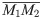
Mapping MT segments from the 2D plane back to the 3D surface.The inverse quaternion rotation operator of ΔABC is applied to the MT segment M1M2¯, and a similar operation is performed on MT segment M2M3¯ of ΔADC. If ΔABC and ΔADC are connected to each other via the edge AC, the MT segments M1M2¯ and M2M3¯ also get reconnected in their 3D position.